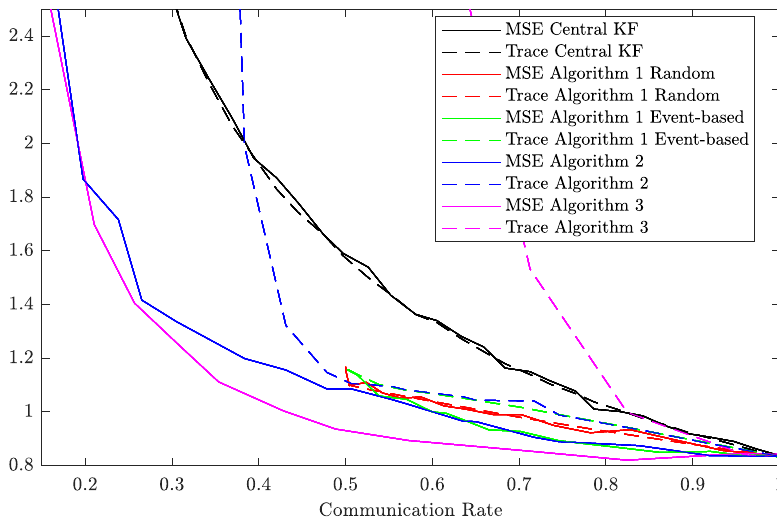
Figure 1. MSEs and traces of the error covariance matrices are plotted relative to the communication rate. Each communication rate corresponds to one Monte Carlo simulation with 500 runs over 100 time steps. MSEs are shown as solid lines, traces are shown as dashed